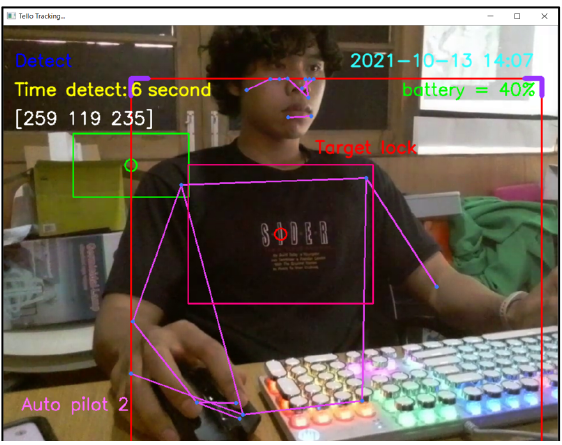
Figure 13. Example outputs and indicators for convenience of